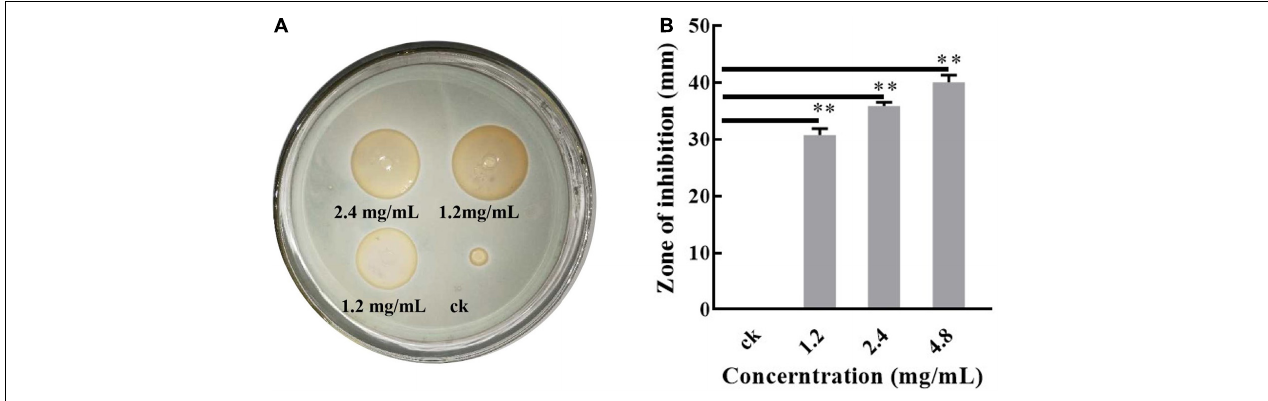
FIGURE 1 | Antibacterial test of the X33 antifungal extract against P. digitatum . Results of standard deviations present in three individual experiments. ** p < 0.01.